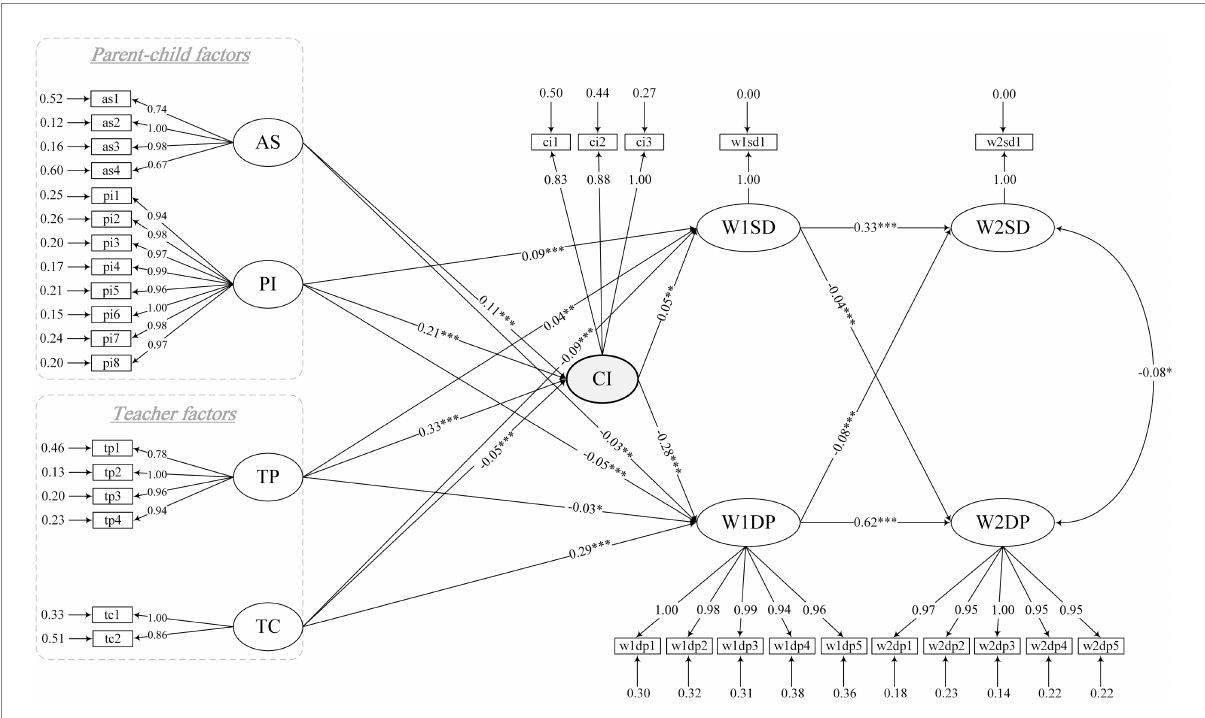
FIGURE 2 Model diagram of the mediating effect of collective integration on sleep duration and depression among adolescents. In this model, sex, live with parents (Yes or No), and parental highest education level are taken as control variables. AS, Academic self-efficacy; PI, Parental involvement; TP, Teacher praise; TC, Teacher criticism; CI, Collective integration; W1SD, Sleep duration in2013-2014; W1DP, Depression in 2013–2014; W2SD, Sleep duration in 2014–2015; W2DP, Depression in 2014–2015. * p < 0.05, ** p < 0.01, *** p < 0.001.